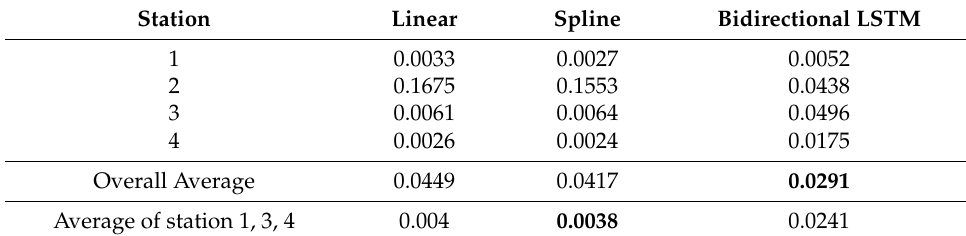
Table 5. RMSE resulting from data filling